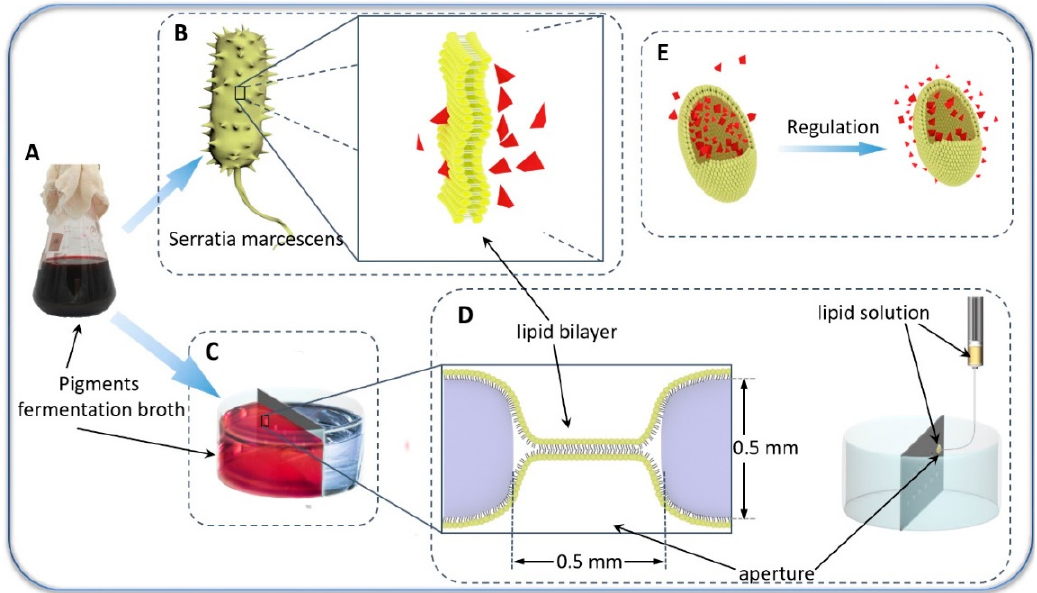
Figure 1. Schematic depiction of the biomimetic membrane platform for transmembrane transport studies of microbial pigments. ( A ) Pyrrole structure nano-pigments fermentation broth. ( B ) Schematic of Serratia marcescens (left) and lipid bilayers (right). ( C ) Schematic of pigments transmembrane transport experiment. ( D ) Preparation process of the biomimetic membrane. ( E ) Schematic illustration of intracellular pigment distribution.